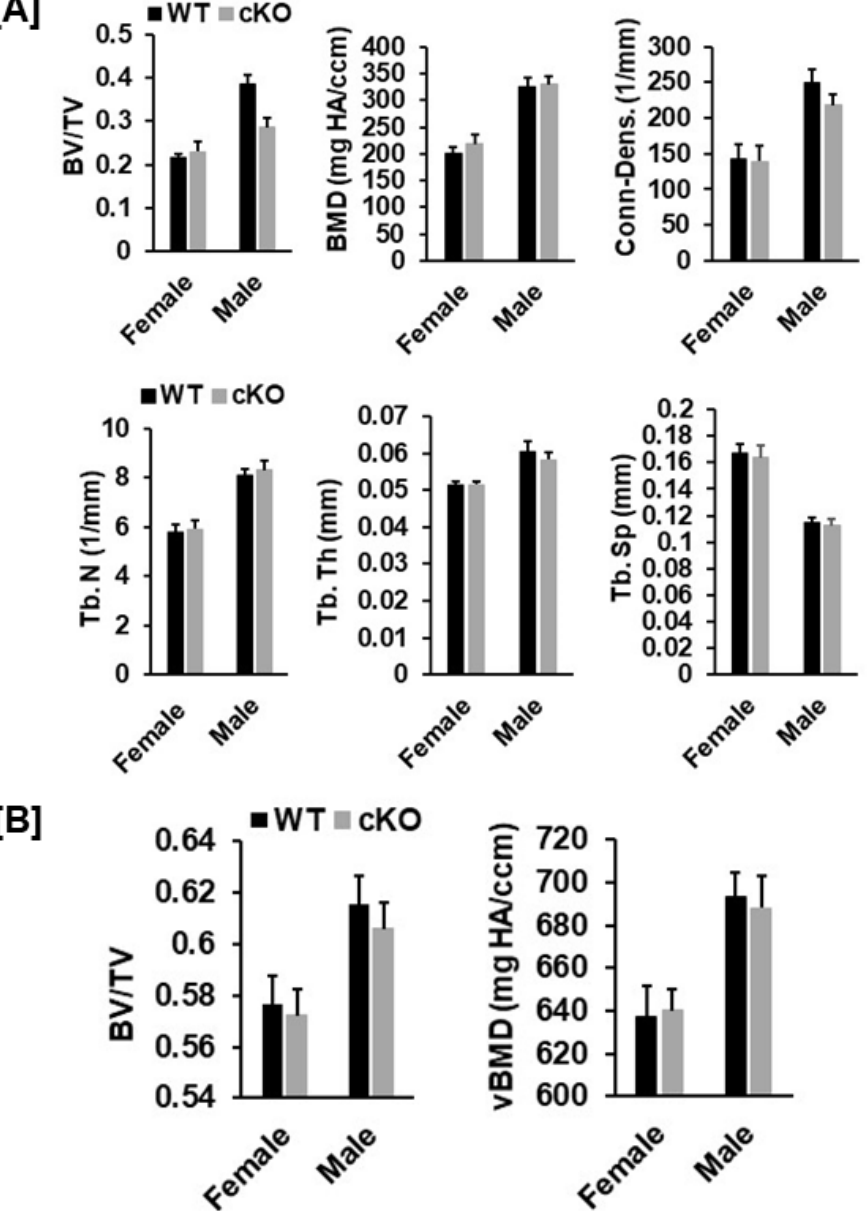
Figure 5. Micro-CT analysis revealed no changes in trabecular and cortical parameters of the tibia of the Phd3 cKO mice at 16 weeks of age. ( A ): Quantitative data of trabecular parameters of the tibia (BV/TV, BMD, Conn-Dens., Tb. N, Tb. Th, and Tb. Sp). ( B ): Quantitative data of cortical BV/TV and BMD of the tibia.